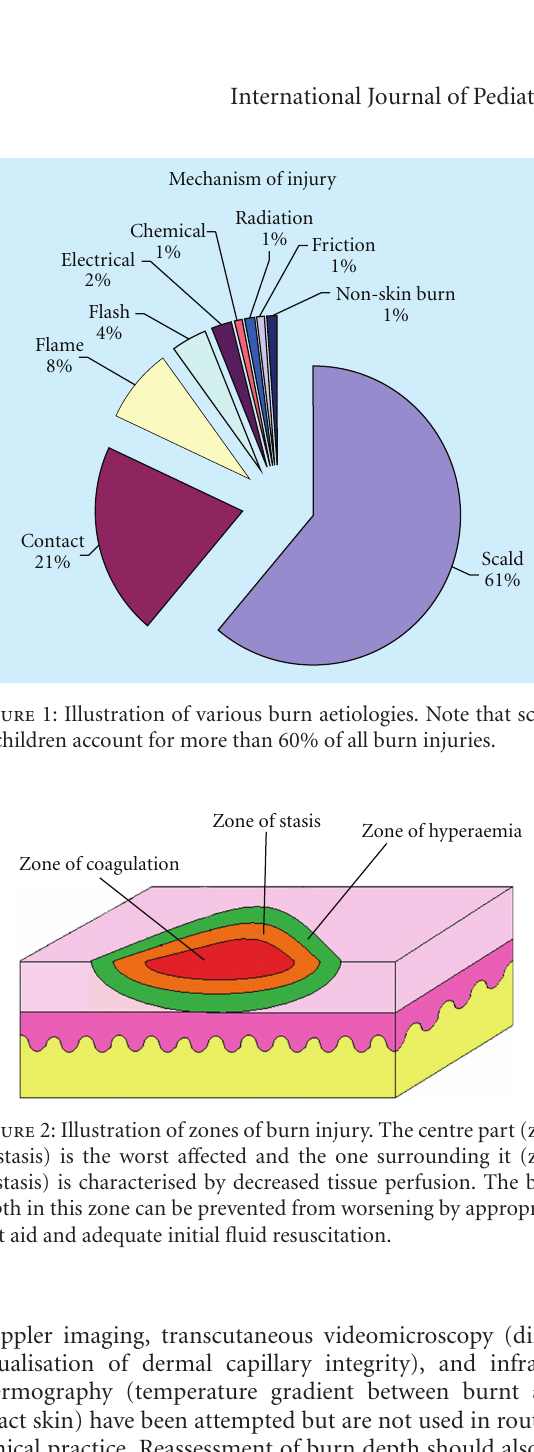
Table 1: Sources of scientific evidence and selection criteria. The scientific evidence for the preparation of this article was obtained by searching Medline, Ovid, Burns and the Cochrane library until June 2010 for randomised controlled trials, systematic